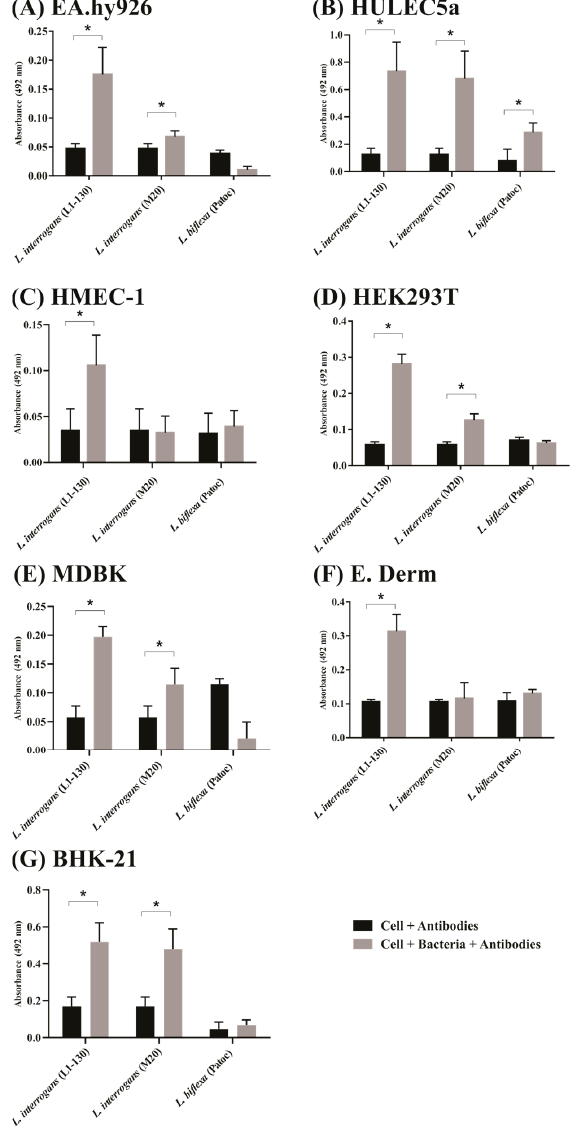
Figure 1. Virulent leptospires can bind to endothelial, epithelial and fibroblast cells. Mammalian cells (10 5 cells/well) were seeded in 96-well plates treated with 0.01% poly-L-lysine and grown to confluence at 37 °C under 5% CO 2 for 24 h. L. interrogans serovar Copenhageni L1-130 (virulent strain), L. interrogans serovar Copenhageni M20 (avirulent strain through culture passaging) and L. biflexa serovar Patoc (saprophytic strain) were added in cell culture media with MOI 100 (10 7 leptospires/well) for 2 h. Wells without the addition of bacteria were used as negative control. Samples were incubated with polyclonal anti-leptospires ( L. interrogans or L. biflexa , dilution of 1:1000) followed by anti-hamster IgG-peroxidase (1:5000). The binding of leptospires was compared to the negative controls by the two tailed t -test ( p < 0.05) showed by *. Endothelial cells were represented by ( A ): EA.hy926, ( B ): HULEC5a and ( C ): HMEC-1. Epithelial cells were represented by ( D ):